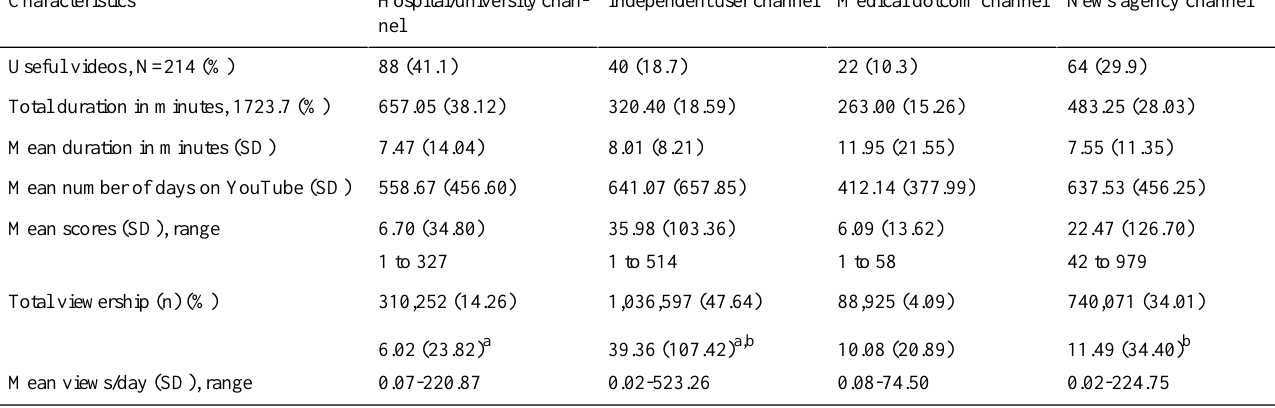
Table 3. Detailed characteristics of “useful videos” on YouTube uploaded by different